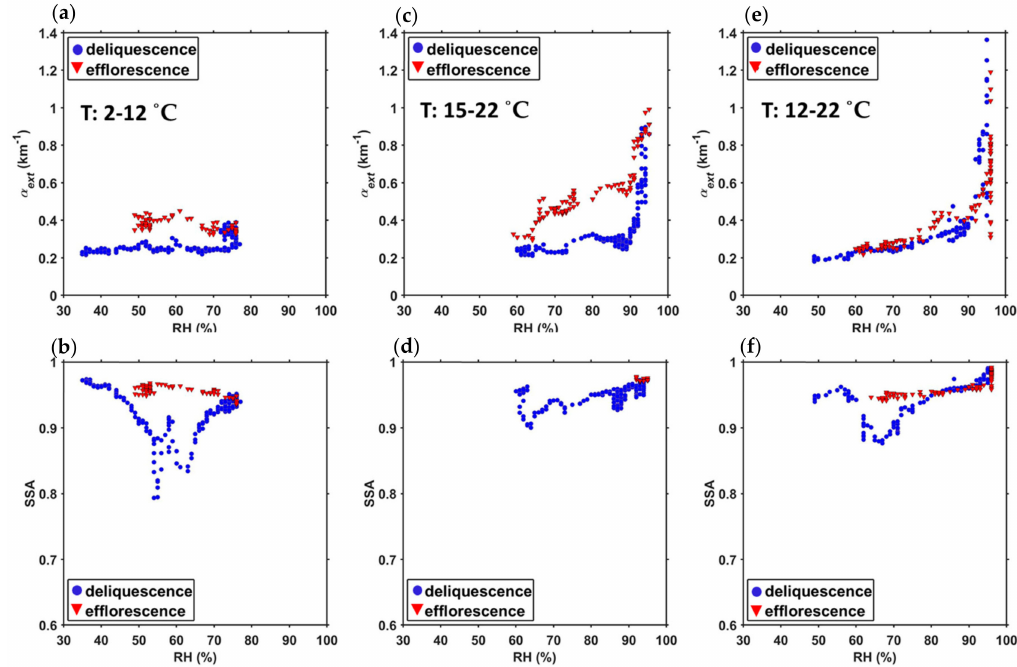
Figure 9. Diurnal variation (1-day cycle) of the α ext and SSA with respect to RH in: ( a , b ) clear-sky days (21–22 November), ( c , d ) cloudy days (3–4 November), and ( e , f ) rainy days (2–3 November). Blue dots indicate the deliquescence phase, while red triangles the e ffl orescence